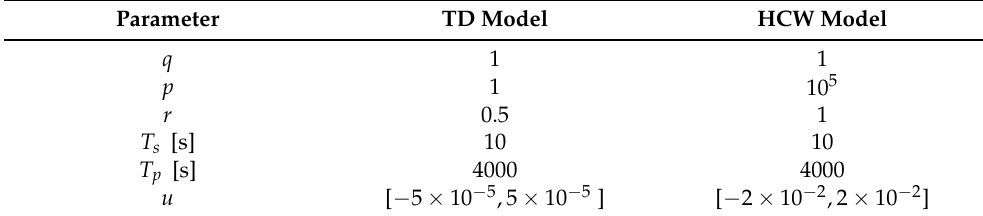
Table 1. MPC tuning and test